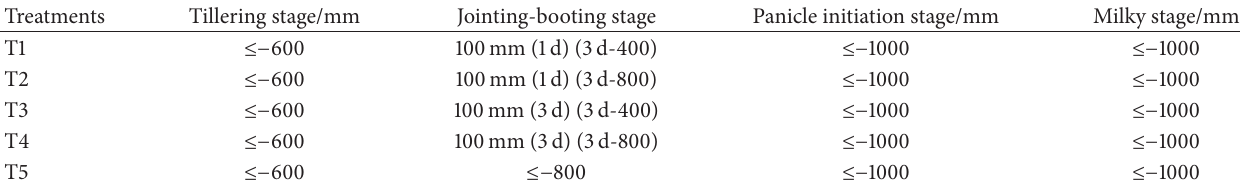
Table 1: Design of controlled drainage scheduling.